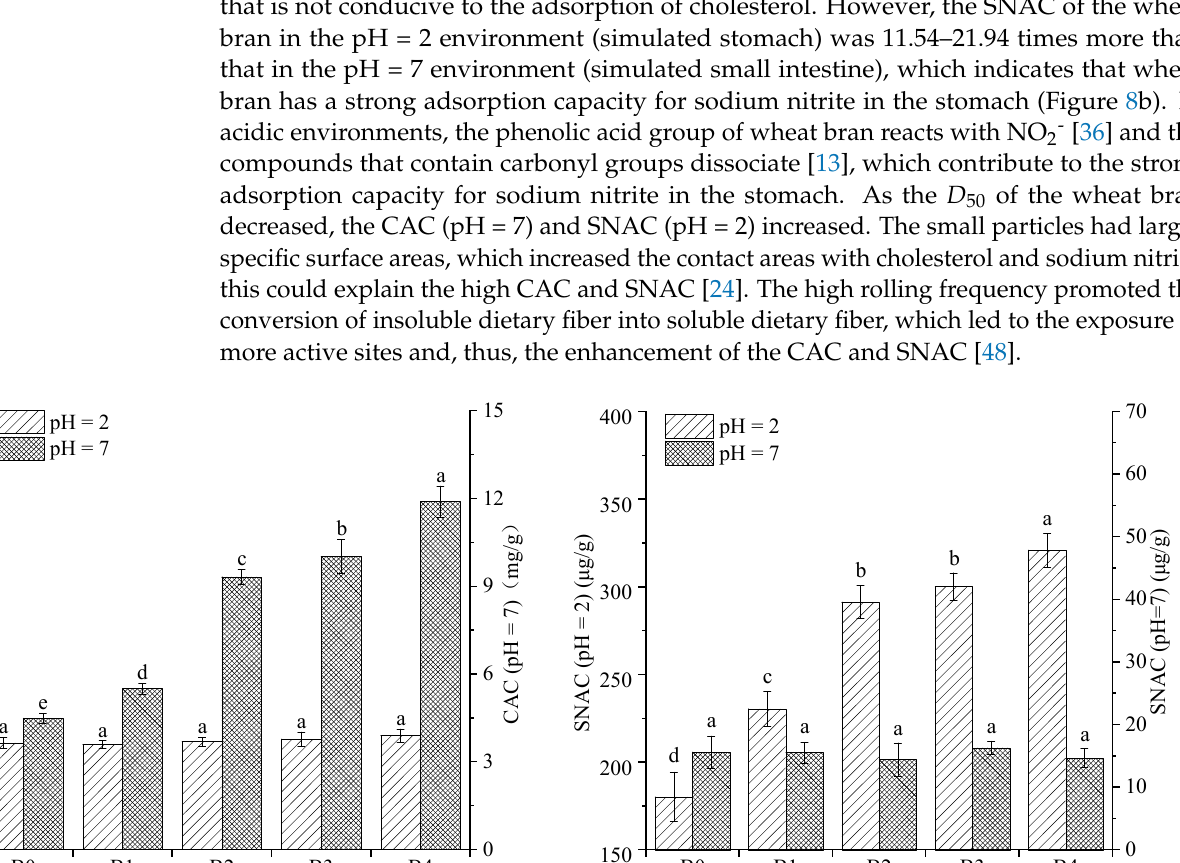
( b )) of the wheat bran. The B0, B1, B2, B3, and B4 are the wheat bran prepared under the rolling